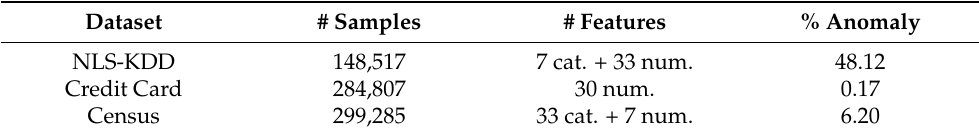
Table 1. Datasets Details. “num.” and “cat.” denote numerical features and categorical features,